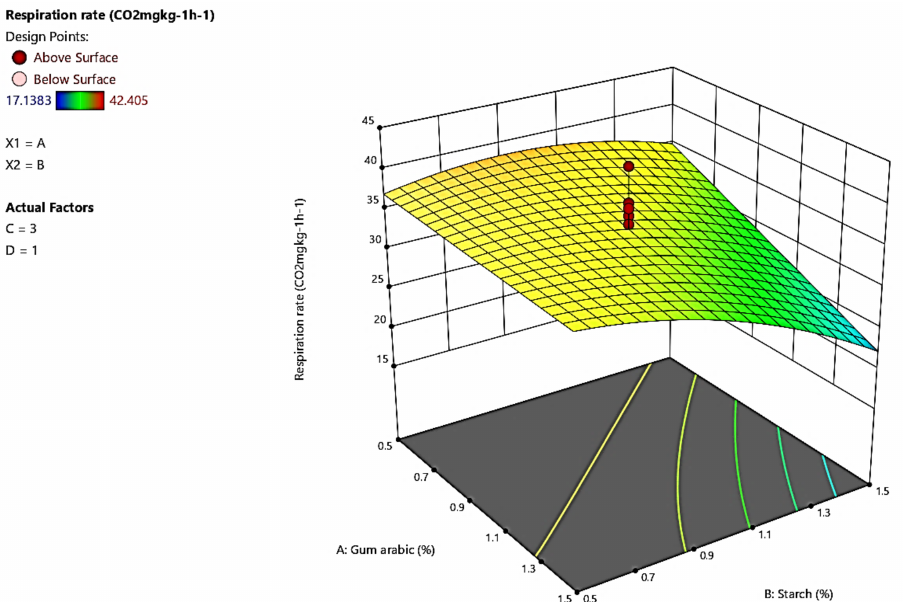
Figure 2. Response surface plot for respiration rate (CO 2 mg · kg − 1 · h − 1 ) of coated “Wonderful” pomegranate as a function of gum arabic and maize starch and